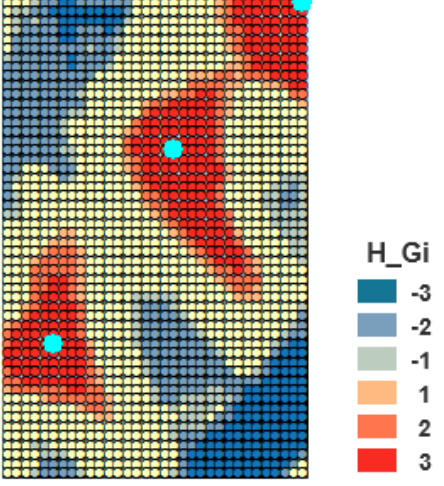
Figure 23. The distribution map for the fourth dataset using our proposed approach.